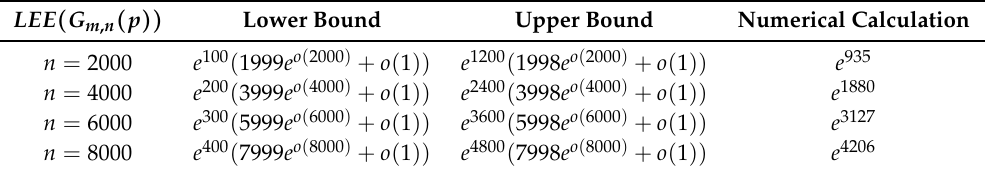
Table 2. LEE ( G m , n ( p )) for m = 2, n ( 1 ) = n /2 and p = 0.1. LEE ( G m , n ( p